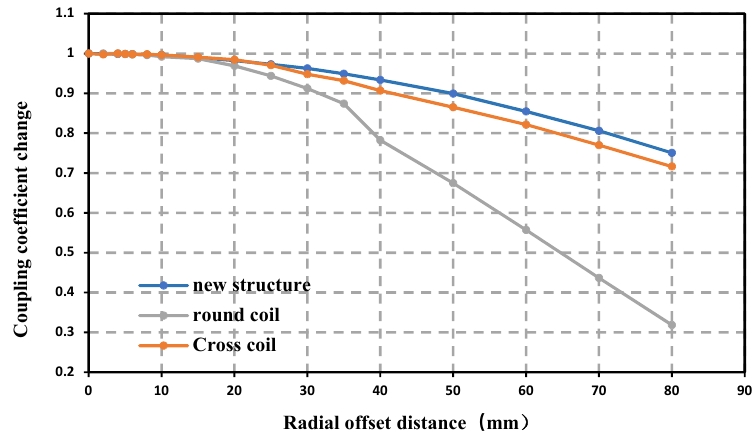
Figure 10. Mutual inductance changes of three coils during offset.